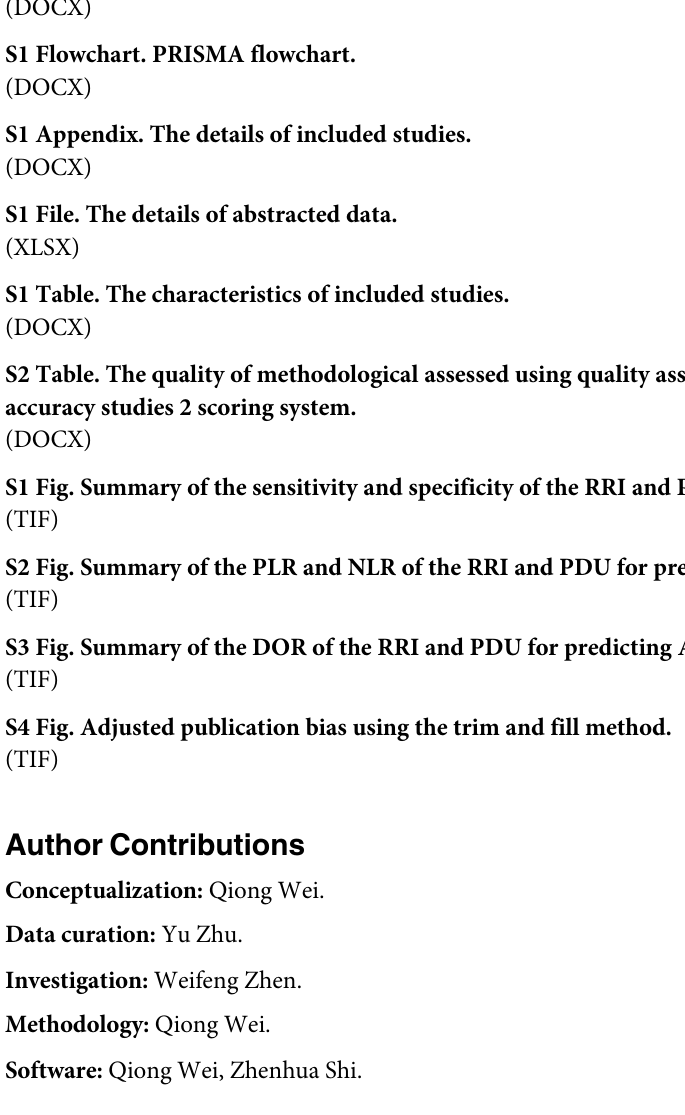
S2 Table. The quality of methodological assessed using quality assessment of diagnostic accuracy studies 2 scoring system. S1 Fig. Summary of the sensitivity and specificity of the RRI and PDU for predicting AKI. S2 Fig. Summary of the PLR and NLR of the RRI and PDU for predicting AKI. S3 Fig. Summary of the DOR of the RRI and PDU for predicting AKI. S4 Fig. Adjusted publication bias using the trim and fill